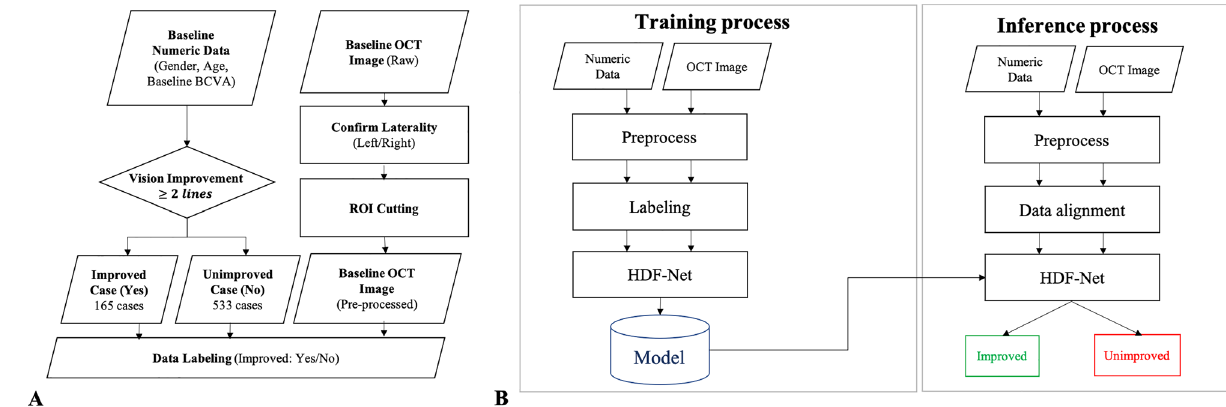
Figure 1. ( A ) Illustration of the pre-process flow. ( B ) The flowchart of the HDF-Net